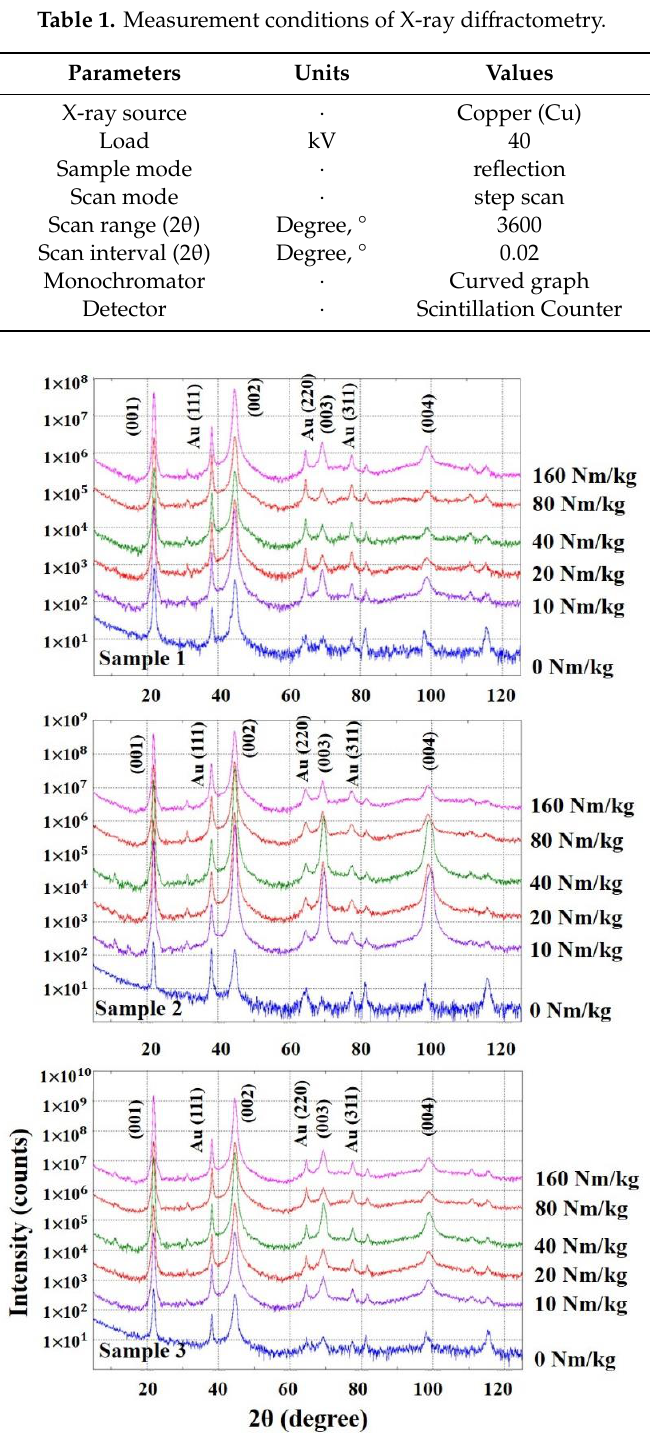
Figure 2. The intensity variation of three PMN-28%PT XRD patterns at (001) plane according to irradiation does irradiation does levels.